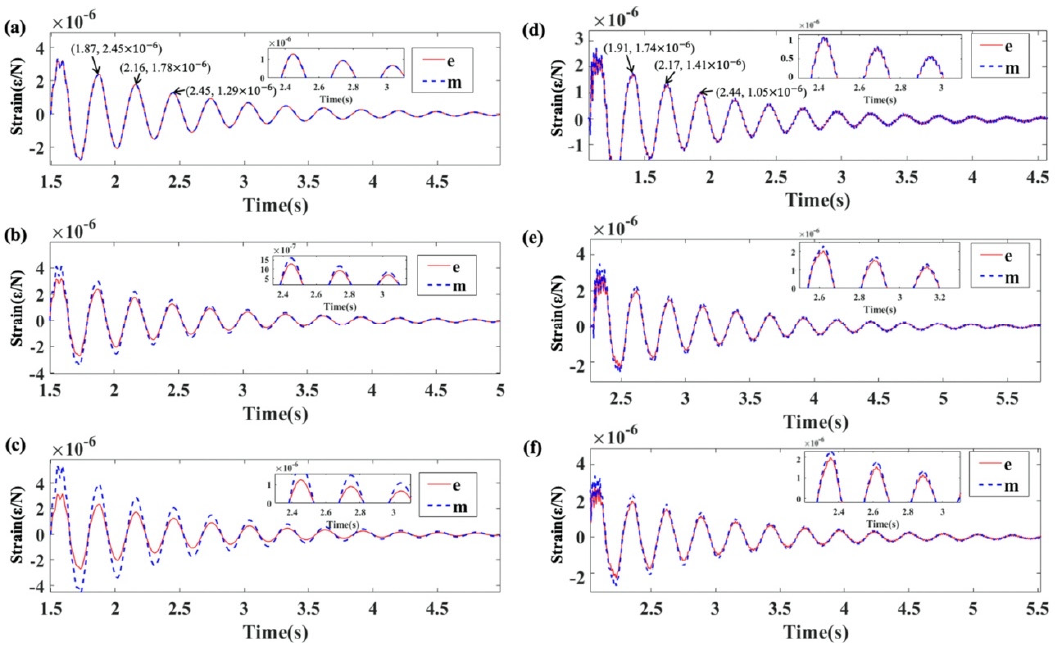
Figure 4. Numerical results of ( a ) INT (intact), ( b ) DL1 (mildly damaged), and ( c ) DL2 (severely damaged); experimental results of ( d ) INT, ( e ) DL1, and ( f ) DL2; “ e ” and “ m ” denote expanded and measured strains.